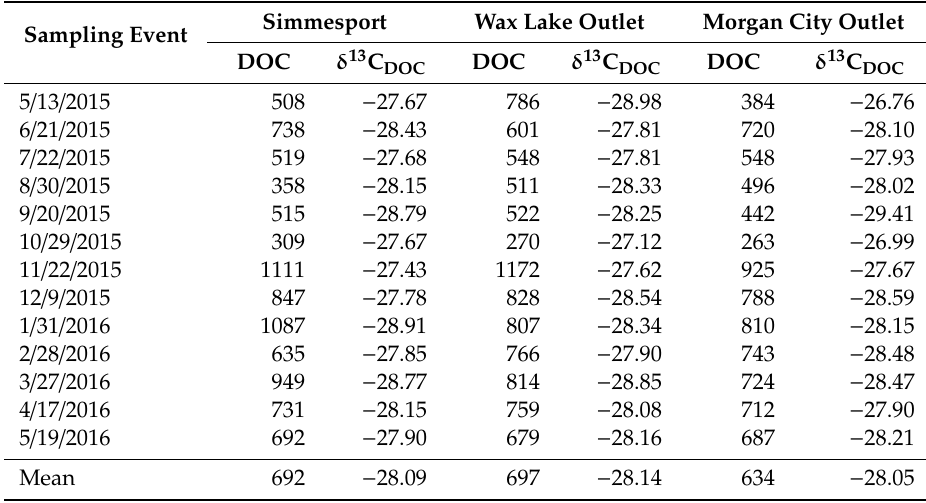
Table 2. Dissolved organic carbon (DOC) concentrations ( µ mol L − 1 ) and δ 13 C DIC (% (cid:24) VPDB) at Simmesport, Wax Lake Outlet, and Morgan City during the 13 sampling